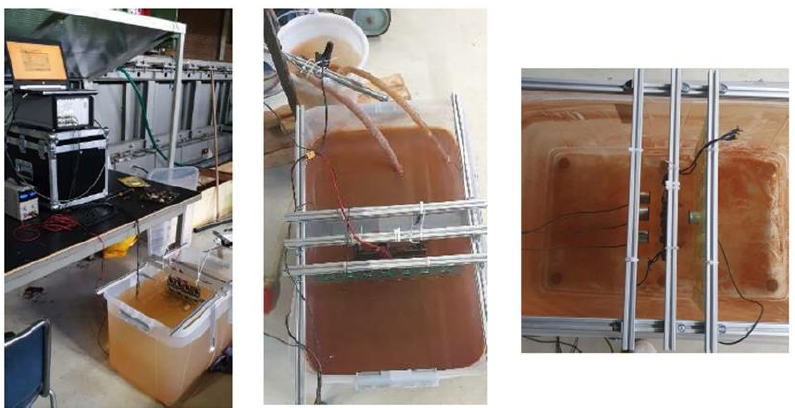
Figure 4. Schematic illustration of accelerated corrosion experiments.